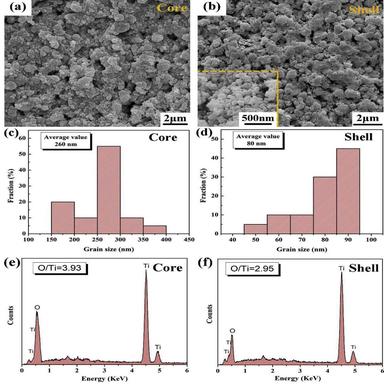
SEM microstructure, corresponding particle size distributions and EDS patterns of the cross section of (a, c, e) Li4TiO4 core and (b, d, f) Li2TiO3 shell.